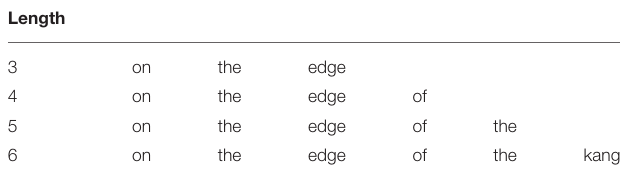
TABLE 2 | Example of expanding lexical bundle in